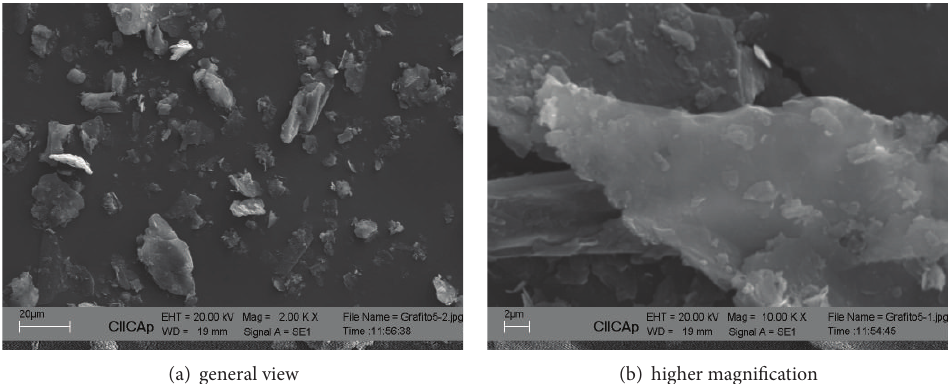
Figure 4: SEM images at of the GO sample pretreated at 700 ∘ C and ultrasonic vibration in H 2 O 2